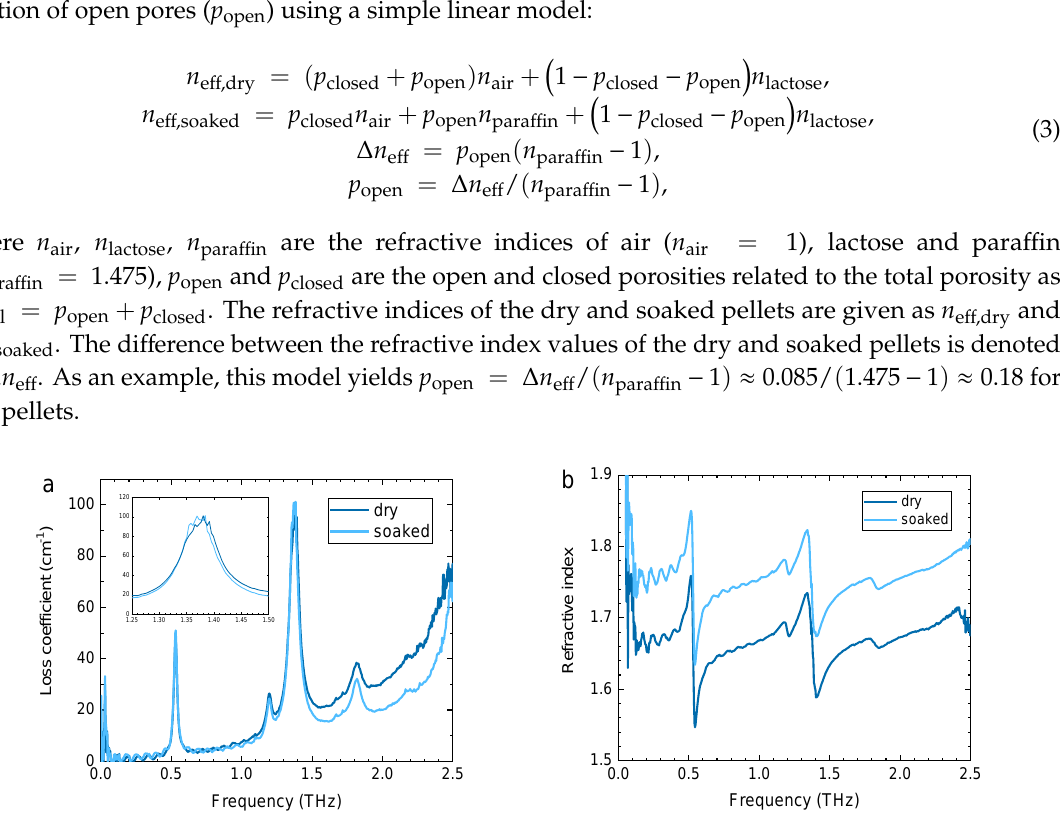
Figure 3. The ( a ) loss coefficient and ( b ) and refractive index of the dry and soaked lactose pellets.